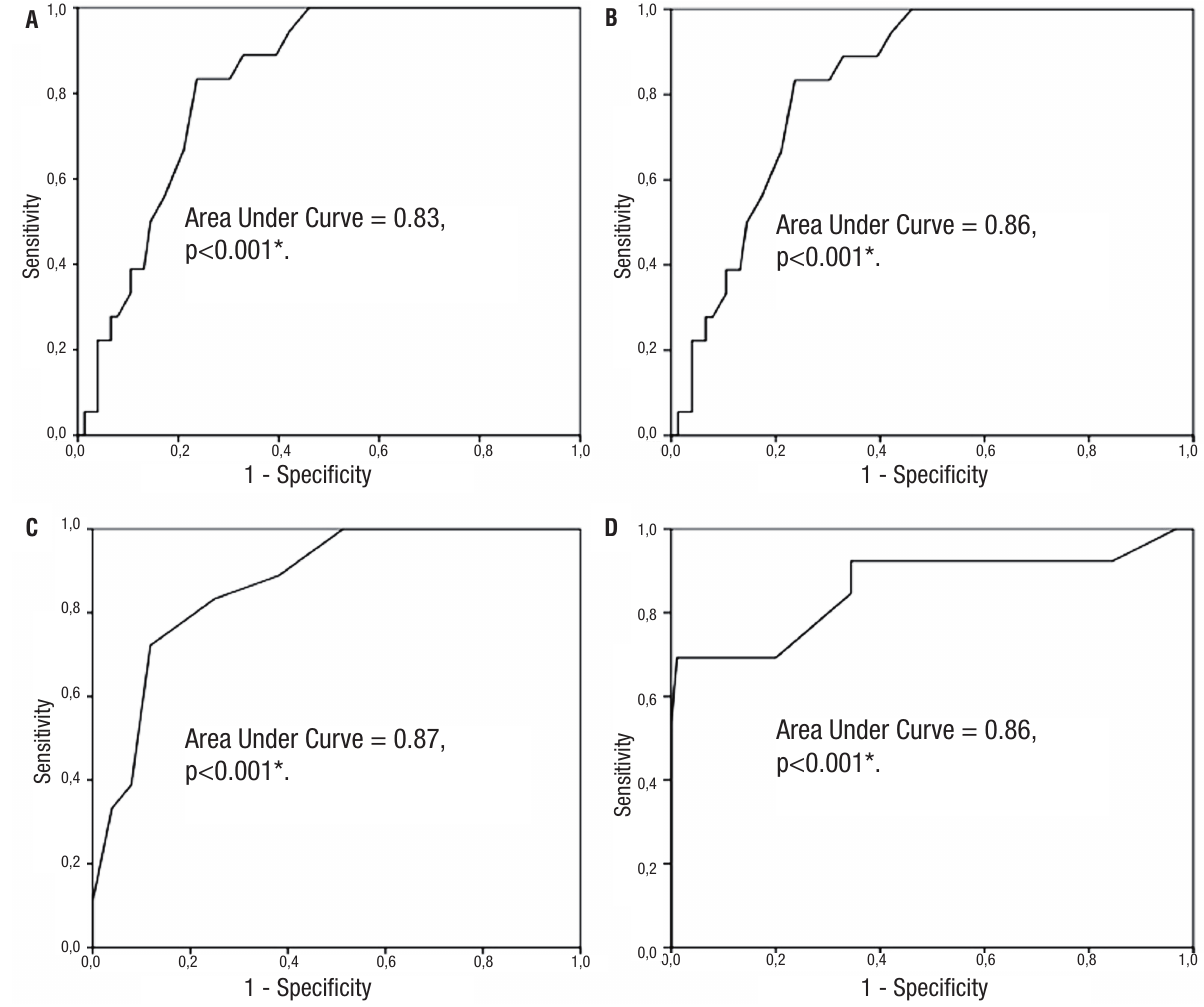
Figure 1 - The cut-off values of neck circumference and waist circumference were drawn with Receiver-operating characteristic curves according to groups. A-The cut-off value for waist circumference in benign prostate hyperplasia patients with metabolic syndrome. B-The cut-off value for waist circumference in benign prostate hyperplasia patients without metabolic syndrome. C-The cut-off value for neck circumference in benign prostate hyperplasia patients with metabolic syndrome. D-The cut-off value for neck circumference in benign prostate hyperplasia patients without metabolic